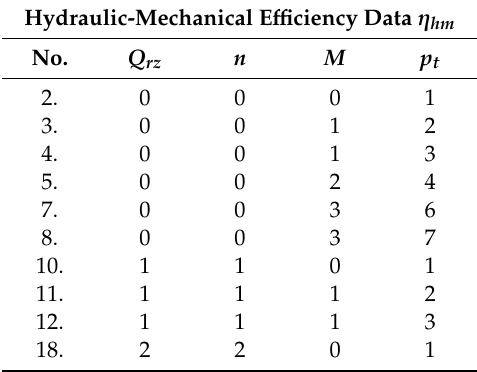
Figure 3. Hydraulic-mechanical efficiency η hm . Table 3. Logically coded data for η hm . The data were from the red tree branches in Figure 3. Table 4. Logically coded data for η c .